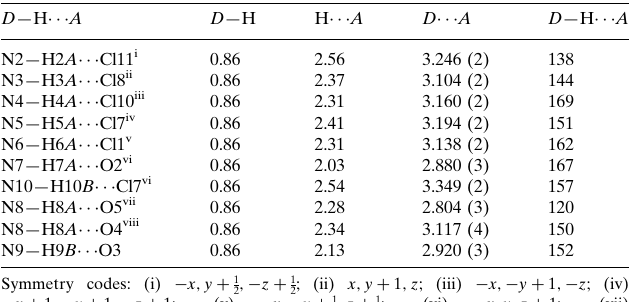
Hydrogen-bond geometry (A˚ , (cid:3) ).